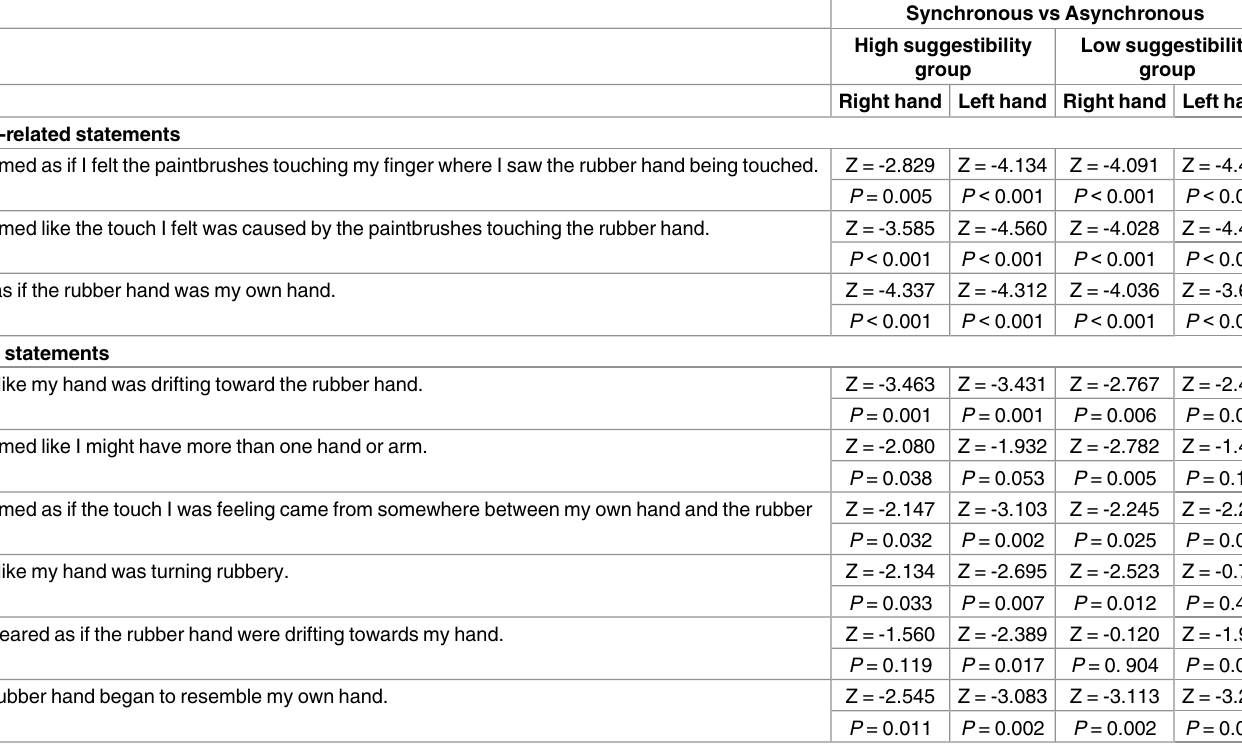
Table 1. Illusion-related and control statements. Statistical results of post-hoc comparisons betweensynchronous and asynchronous conditions in the two groups and in both